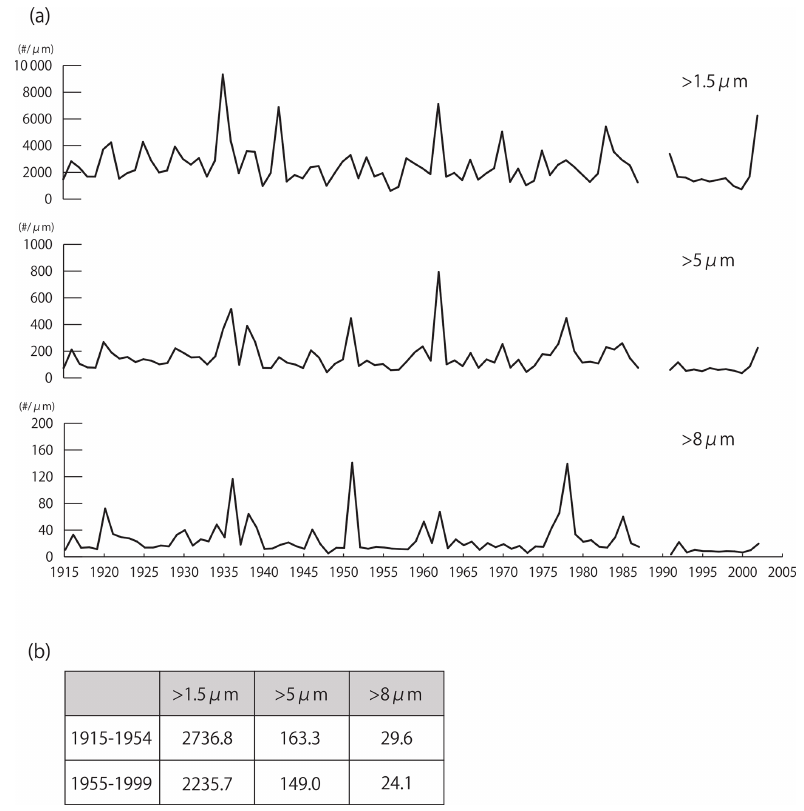
Figure A3. (a) Annual average number concentration of the SIGMA-D ice core dust particles with diameters of > 1 . 5, > 5, and > 8µm from 1915 to 2002 as measured by the Abakus laser particle sensor and (b) the averaged concentrations from 1915 to 1954 and from 1955 to